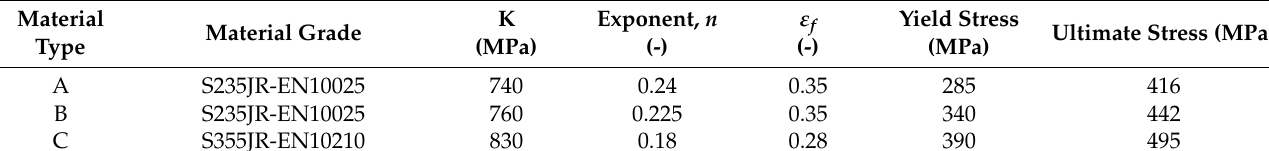
Table 6. The material properties of steel based on [47,48] which were obtained experimentally.